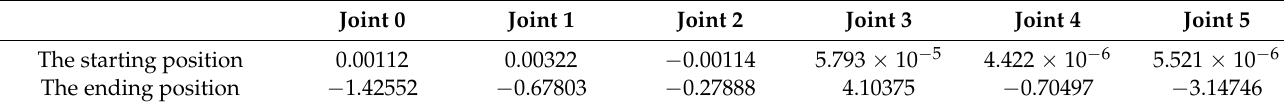
Figure 14. The position change of each joint of the robotic arm. Table 5. Initiation and termination of the robotic arm joint.